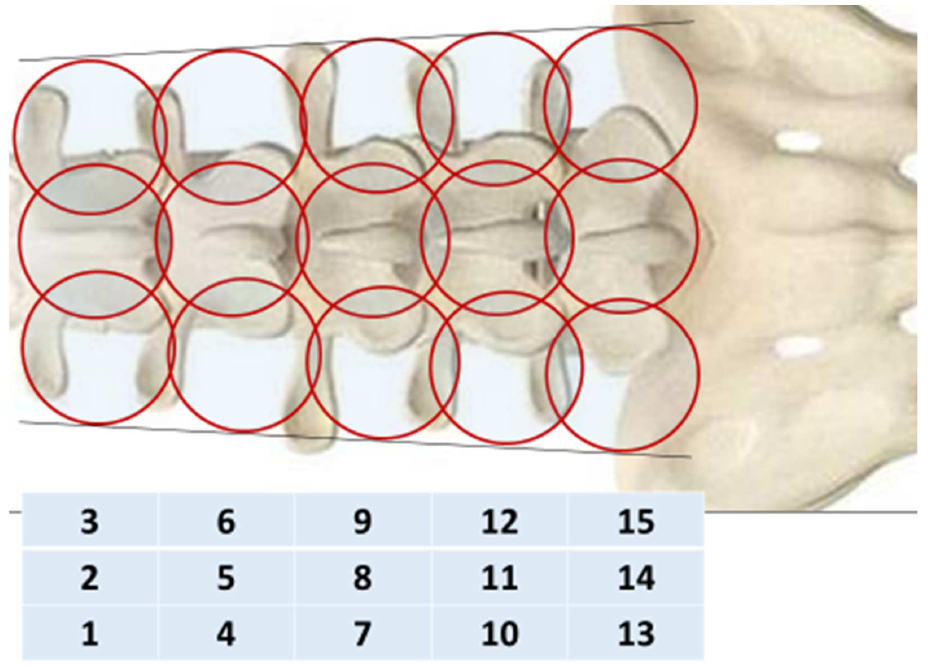
Figure 3. Diagram of the sequence of sensor placement in the study of the lumbar vertebrae by the MWR.